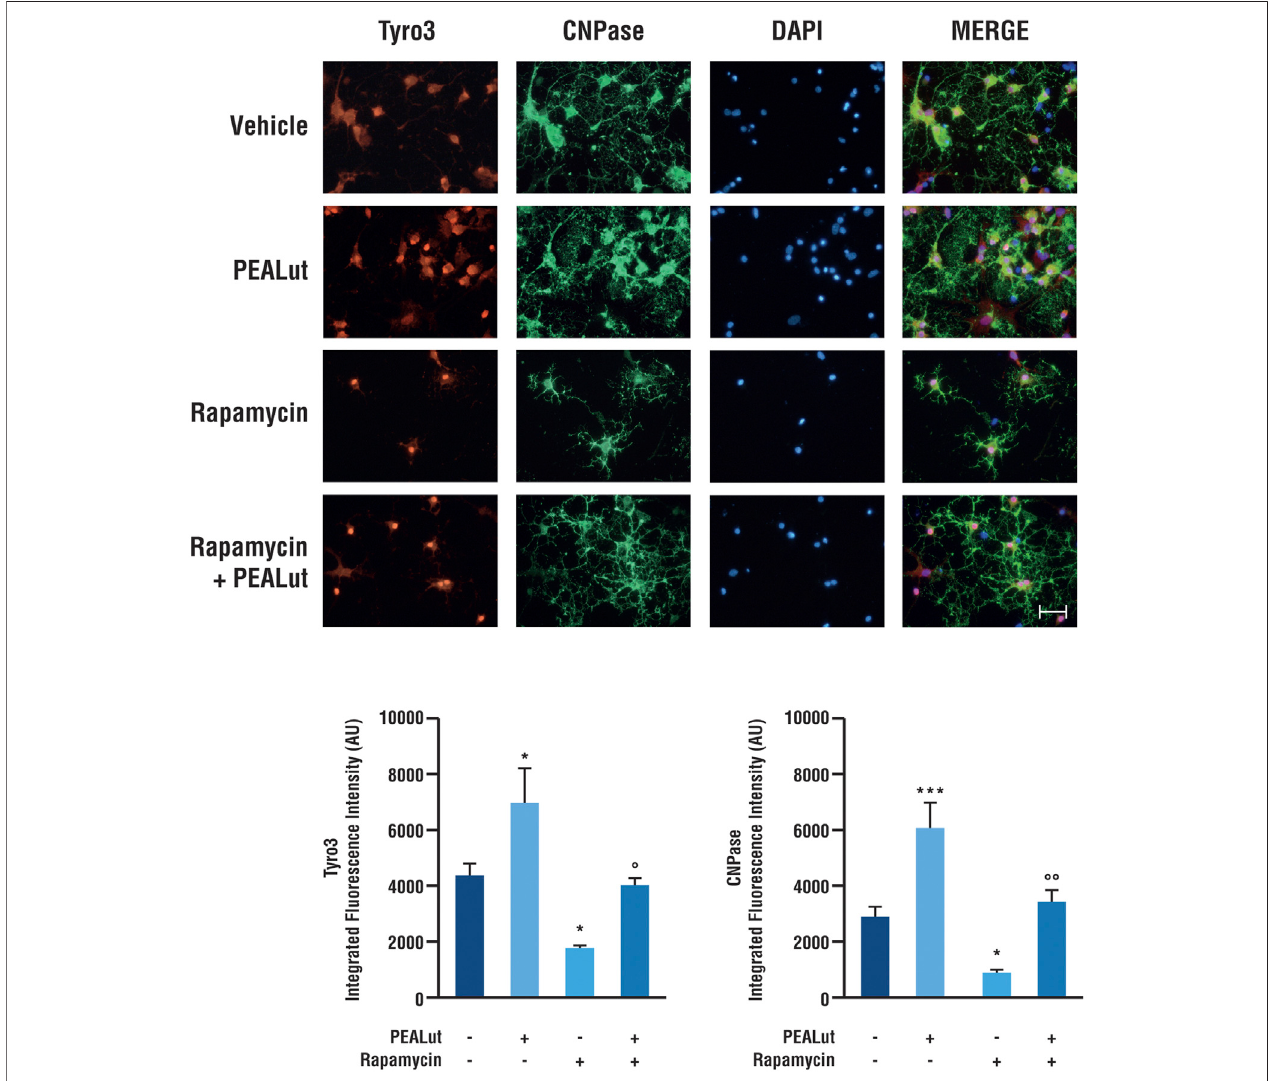
FIGURE3| Tyro3andCNPaseimmunostaininginOPCsatDIV8.CulturesofOPCsweretreatedPEALutatDIV2andprocessedatDIV8forimmuno fl uorescence analysis. Rapamycin was added 30 min before PEALut. Scale bar, 20 μ m. Graphs show the quantitative analysis of the integrated intensity of fl uorescence. Data are expressed as mean ± SEM. Tyro3: * p < 0.05 vs Vehicle; ° p < 0.05 vs PEALut. CNPase: * p < 0.05 vs Vehicle; *** p < 0.001 vs Vehicle; °° p < 0.005 vs PEALut.